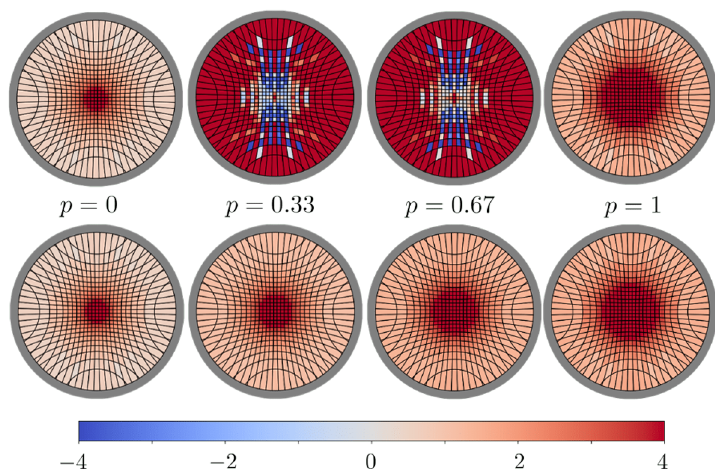
Figure 3. Component h 11 of a mixture of two thermal geometries at two distinct temperatures. Top diagram for G N ≈ 1 and bottom for G N (cid:28) 1 , both with L AdS = 1 . From left to right, we increase the mixing ratio p and the geometry transitions smoothly from one at lower temperature to the other at higher temperature when the gravitational coupling is weak. The reconstruction is dominated by artifacts and have large error if the coupling is strong, leading to a contribution G N H ( p ) in the leading